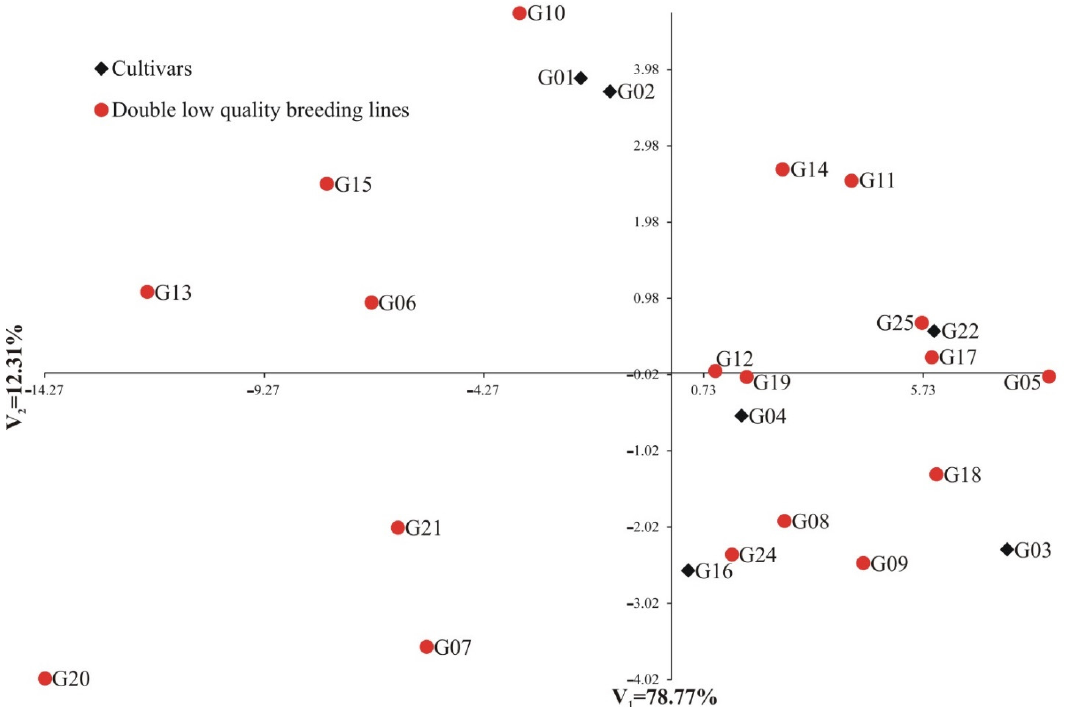
Figure 3. Distribution of 25 genotypes of winter oilseed rape ( Brassica napus L.) in the space of the first two canonical variates in Borowo 2015. first two canonical variates in Borowo